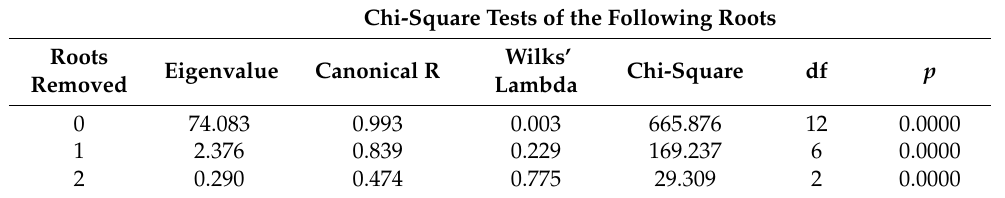
Table 5. Summary of the results of the Chi-square test.